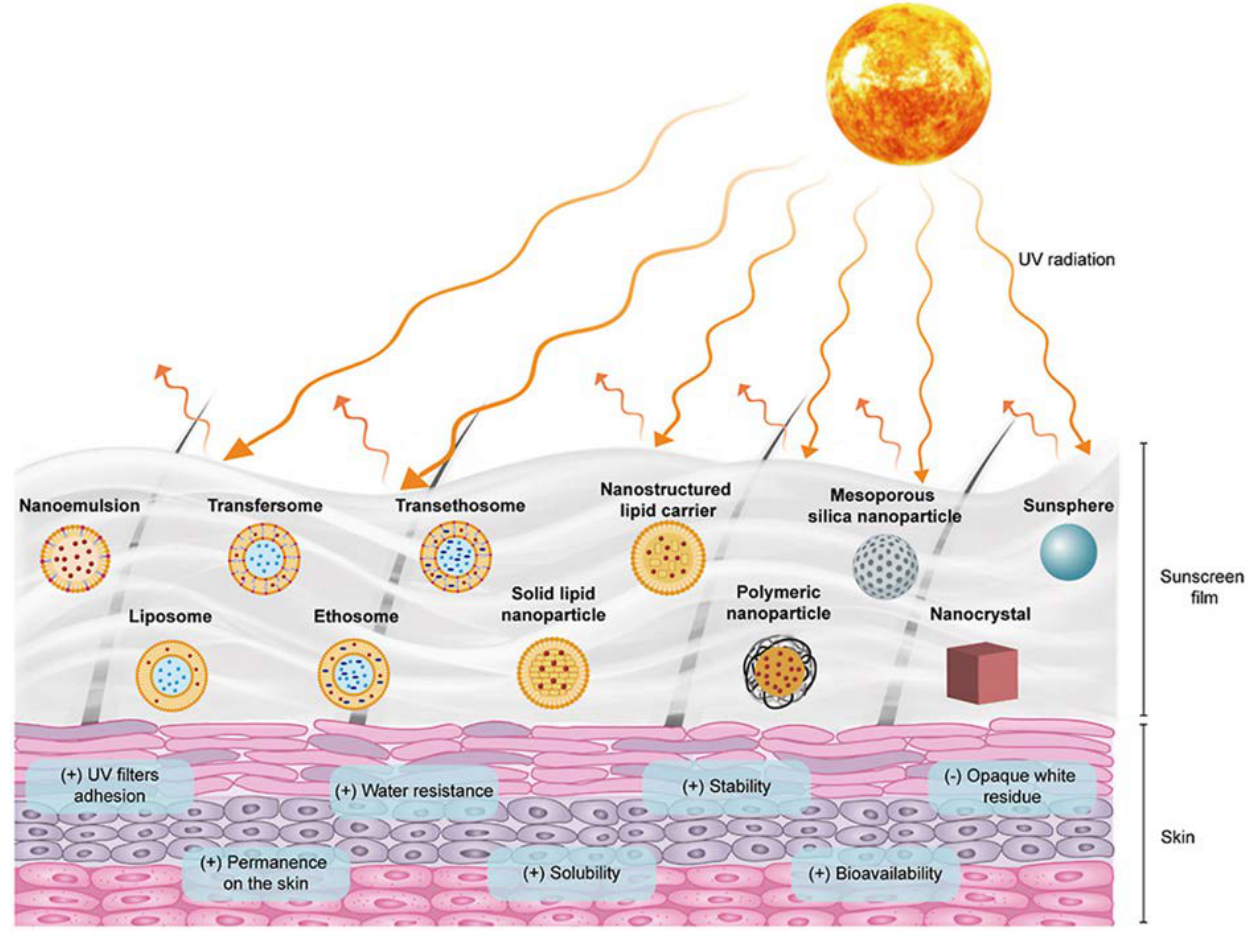
Figure 5. Multifunctional role of flavonoid-loaded nanoparticles in sunscreen products. Reprinted with permission from [117].